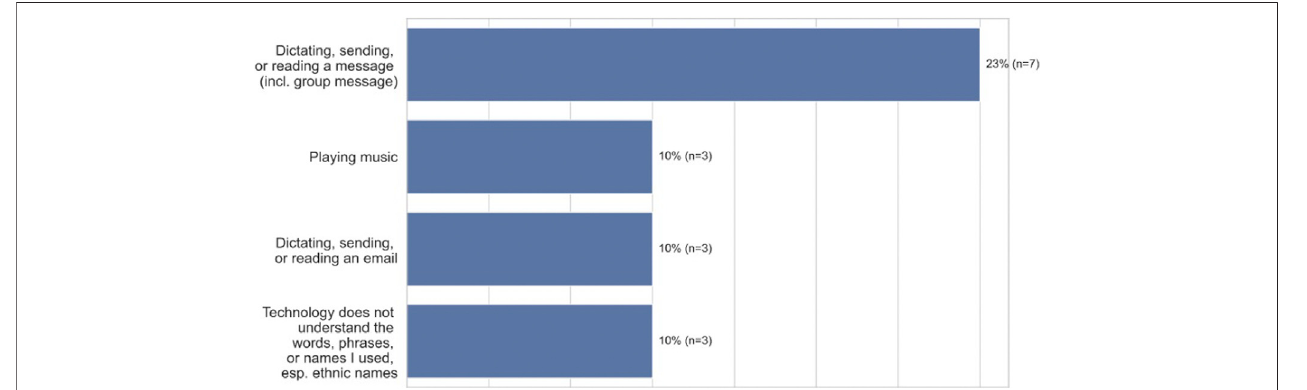
FIGURE 1 | Lack of Satisfaction of ASR Technology among African-American participants ( n (cid:1)